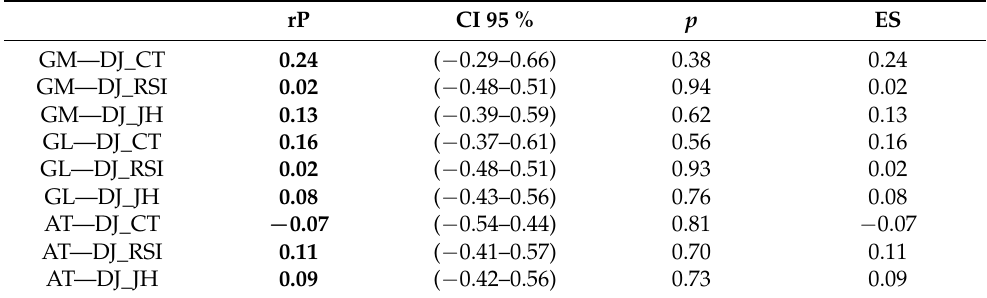
Table 2. Pearson’s correlation(=rP) between drop jump (DJ) performance values (CT—ground contact; RSI—reactive strength index; JH—jump height) and the stiffness of the gastrocnemius medialis (GM), gastrocnemius lateralis (GL), and Achilles tendon (AT). The correlation is in bold; CI—confidence interval; ES—effect size.